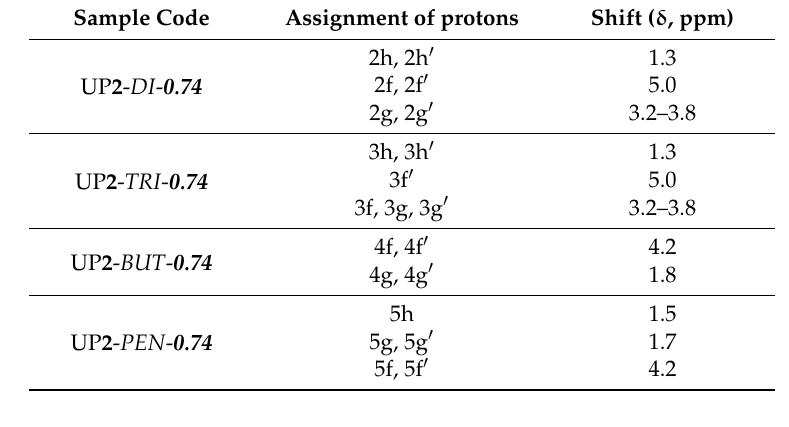
Table 3. Proton chemical shifts for the chain extended hard segments of samples UP 2 - DI - 0.74 , UP 2 - TRI - 0.74 , UP 2 - PEN - 0.74 and UP 2 - BUT - 0.74.